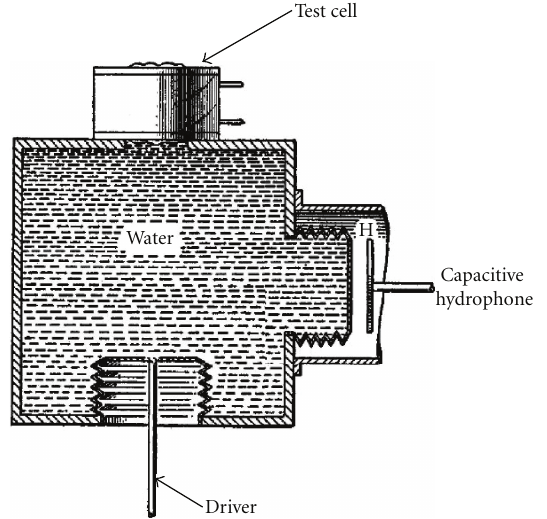
Figure 2: The sylphon bellows is driven by a geophone-type push- pull driver to apply a sinusoidal motion to the sample (modified from [59]).